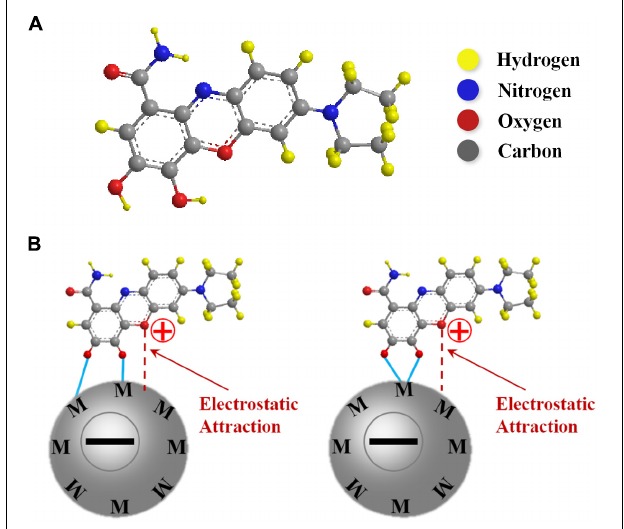
FIGURE 2 | SEM for Zn-Fe-DH -MWCNT at (A,B) different magnifications.